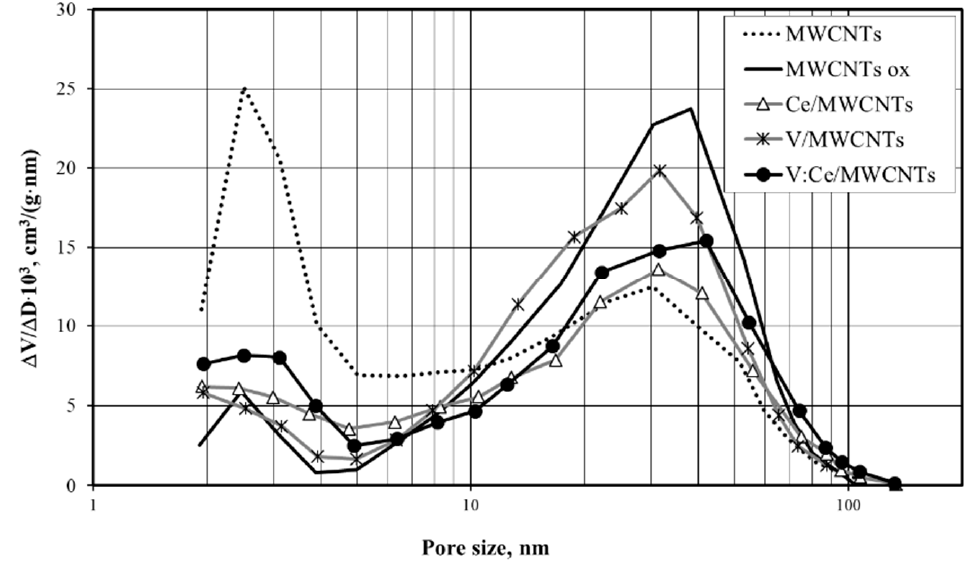
Figure 8. Pore volume distribution of samples of fresh, oxidized MWCNTs and metal oxide-modified MWCNTs.